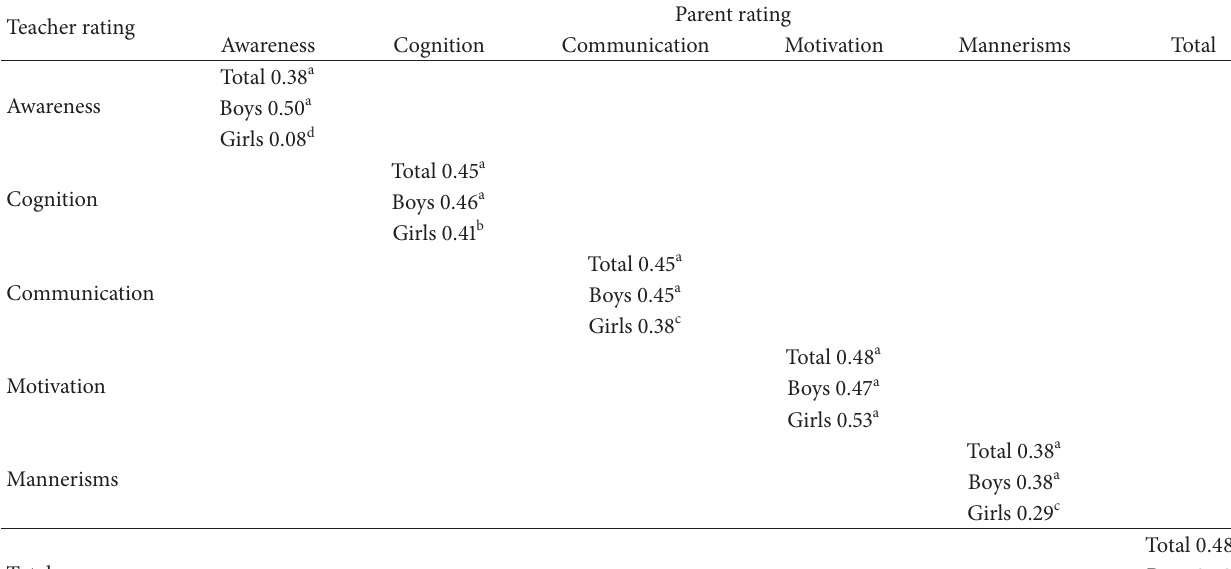
Table 3: Intraclass correlation coefficients ( 𝑁 = 109 ).